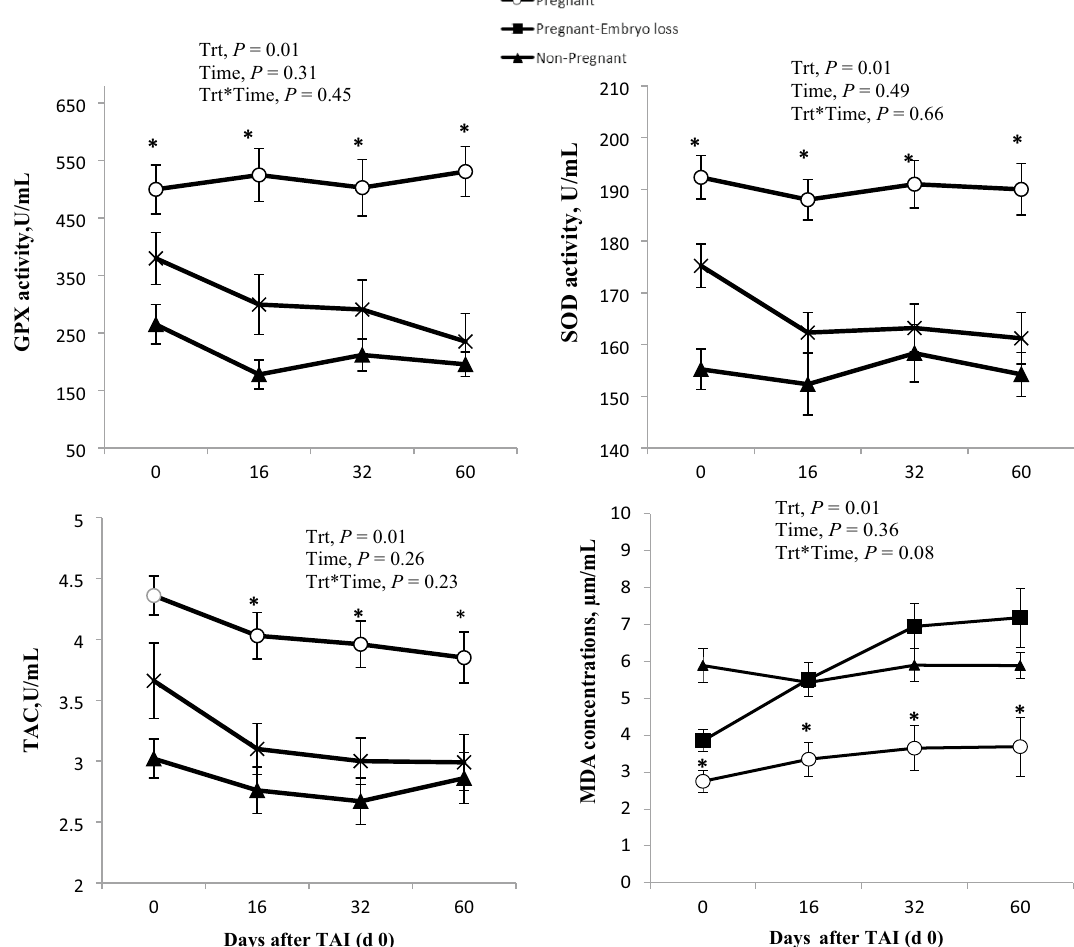
Figure 2. Mean activity of glutathione peroxidase (GPX, U/mL), superoxide dismutase (SOD, U/mL), total antioxidant capacity (TAC) and concentrations of malondialdehyde (MDA) of non-pregnant, pregnant and pregnant lactating dairy cows with embryo loss between day 16 and 32 days after TAI (day 0). Synchronization sequence started at 30 days postpartum. Values are Means ± standard error of means. Asterisks indicate a significant statistical difference at each specific day between pregnant (White) and non-pregnant (Black) lactating cows (P <